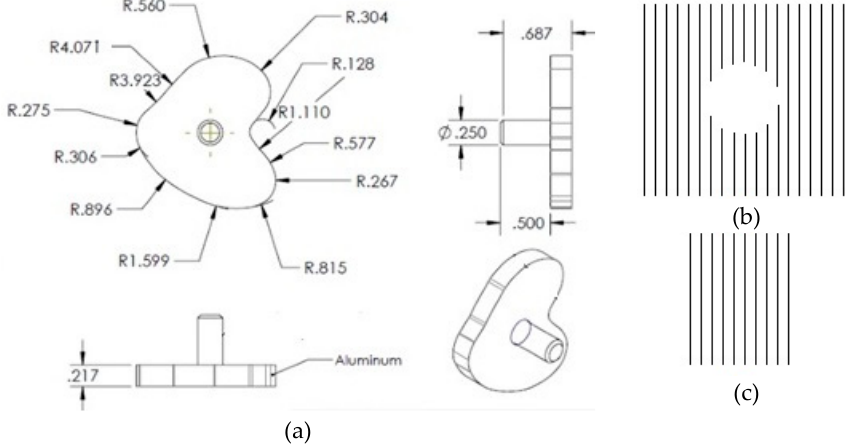
Figure 2. ( a ) Bottom, front, side, and isometric views of a tibial tray implant which was used to manufacture the TT implant. Schematic representation of diagrams used to produce laser patterning on the ( b ) bottom flat and ( c ) keel surface. The gap between two lines was 300 µm.